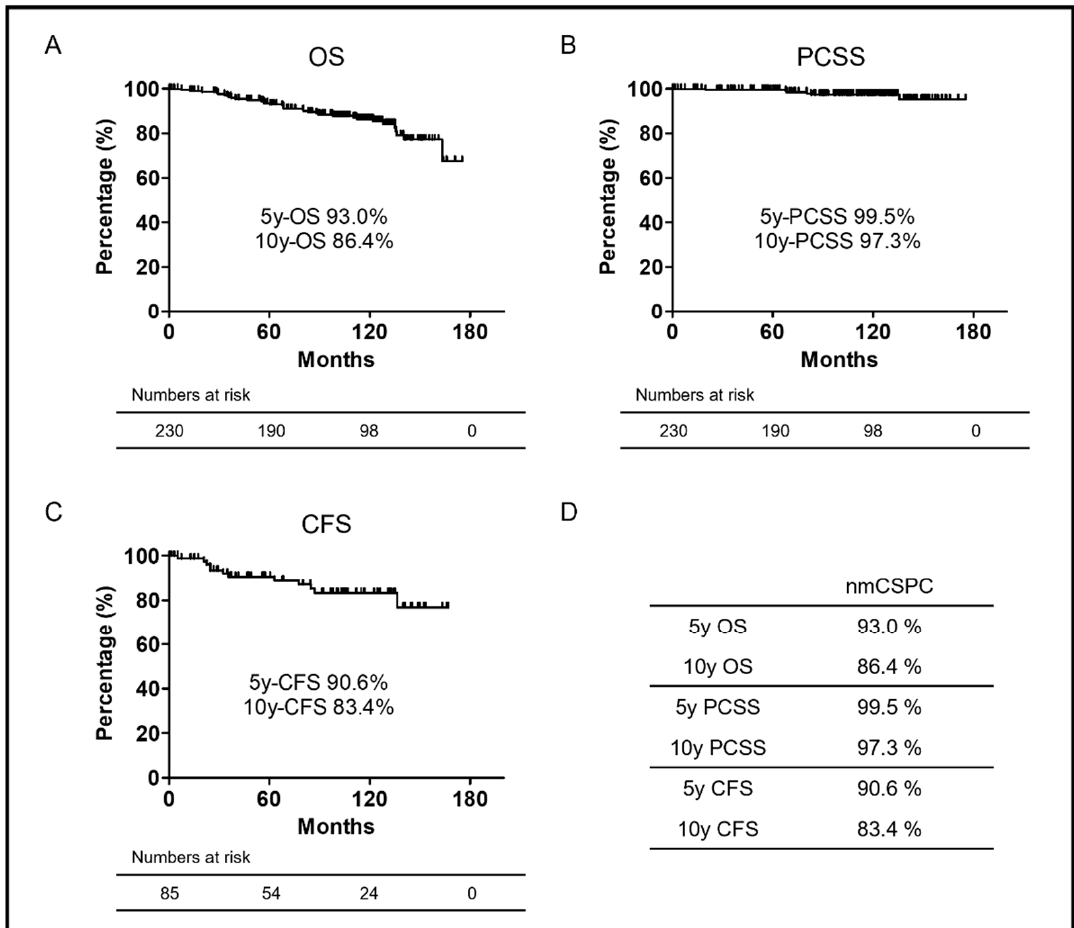
Figure 1. ( A ) Kaplan–Meier curves of OS in nmCSPC. ( B ) Kaplan–Meier curves of PCSS in nmCSPC. ( C ) Kaplan–Meier curves of CFS in in nmCSPC. ( D ) OS, PCSS, and CFS rate at five or 10 years in nmCSPC. Numbers at risk for each group are shown at the bottom of the figure. OS, overall survival; PCSS, prostate-cancer-specific survival; CFS, castration-resistant prostate-cancer-free survival; and nmCSPC, non-metastatic castration-sensitive prostate cancer.